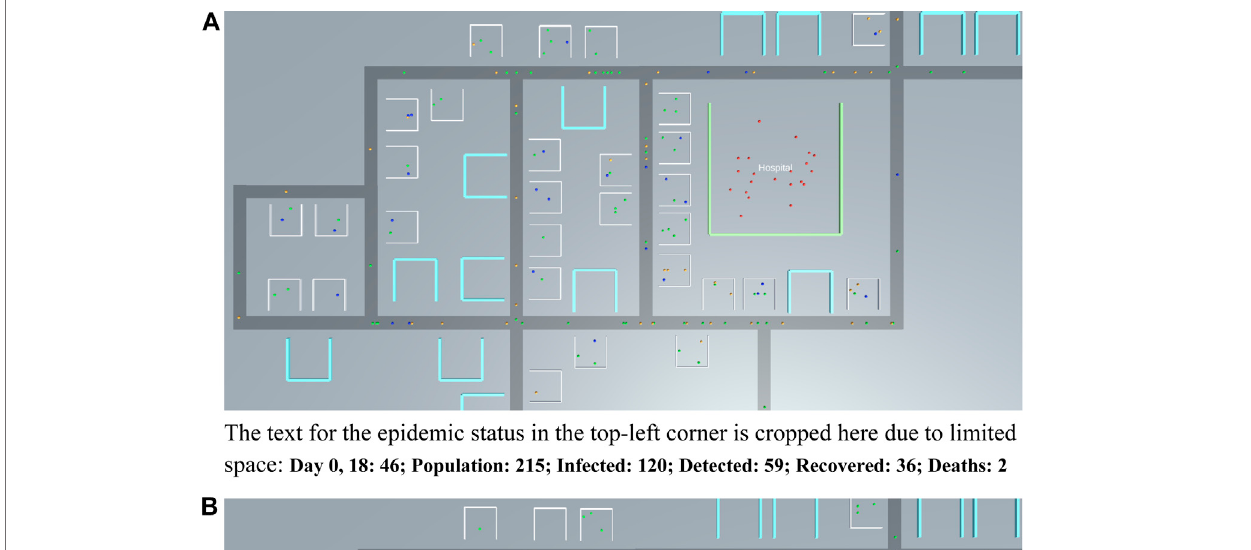
Frontiers in Computer Science |